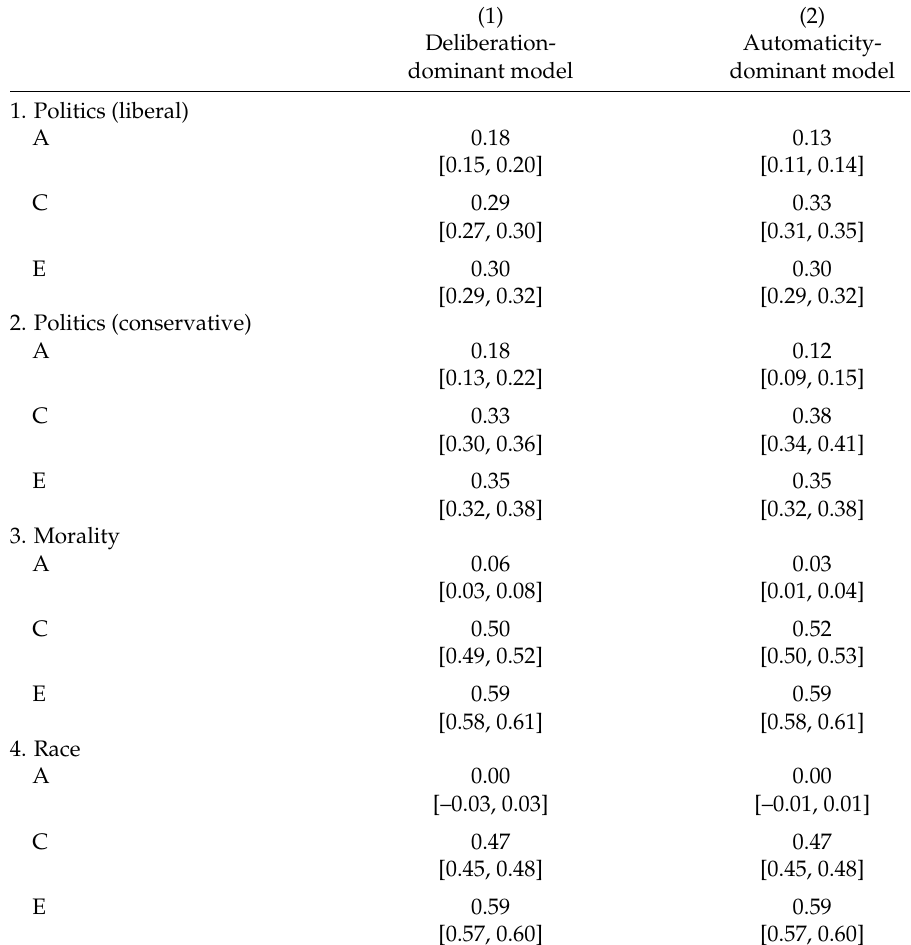
Table 2: Parameter estimates for the deliberation-dominant model in the